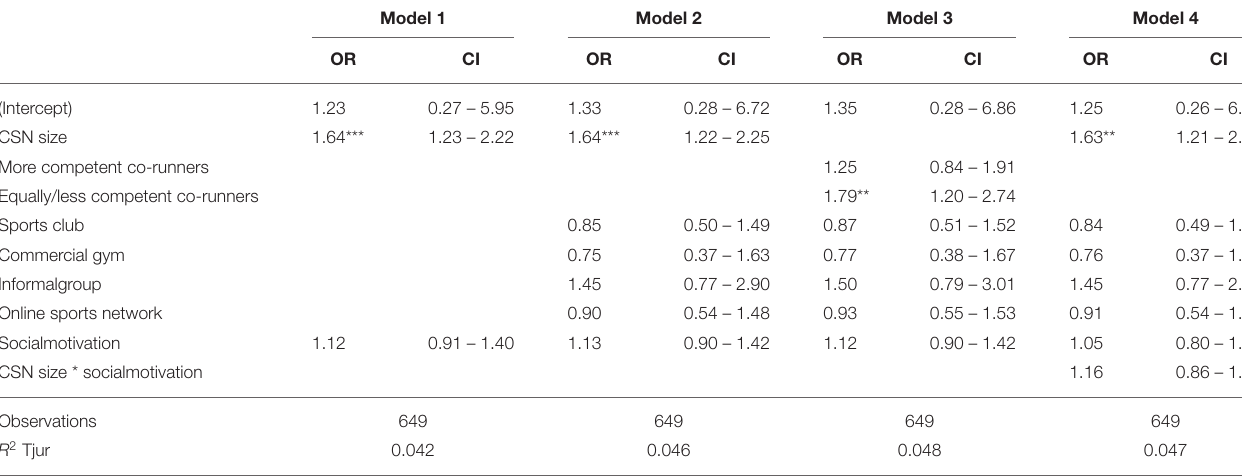
TABLE 3 | Lagged logistic regression effects on showing up at a running